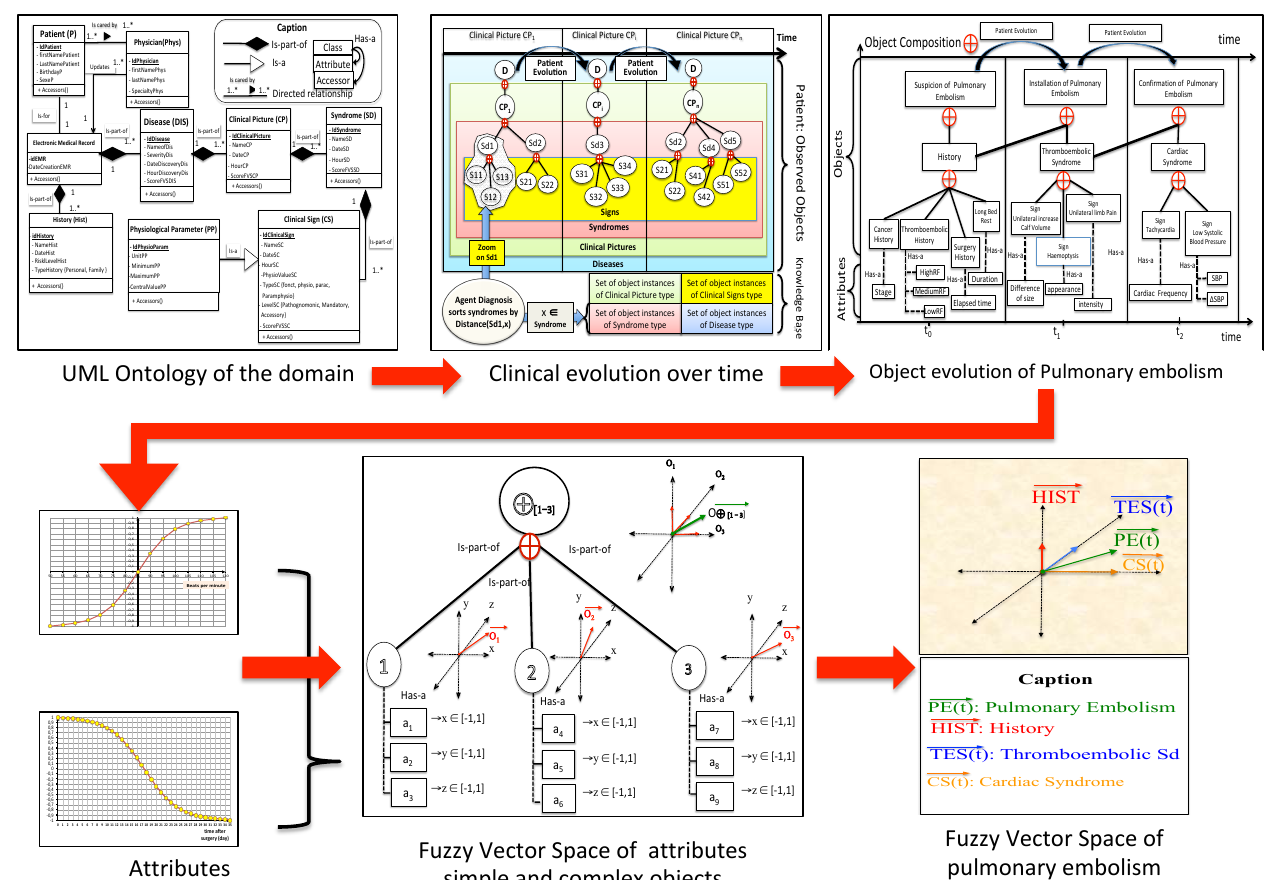
Figure 14. The graphical summary of pulmonary embolism modeling with